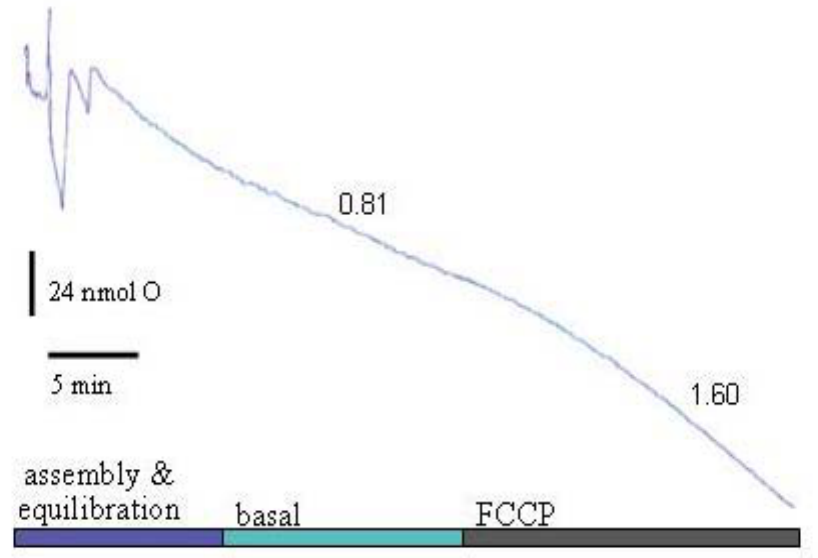
Figure 4. Representative granule neuron oxygen recording using the 2-well chamber system described in Figure